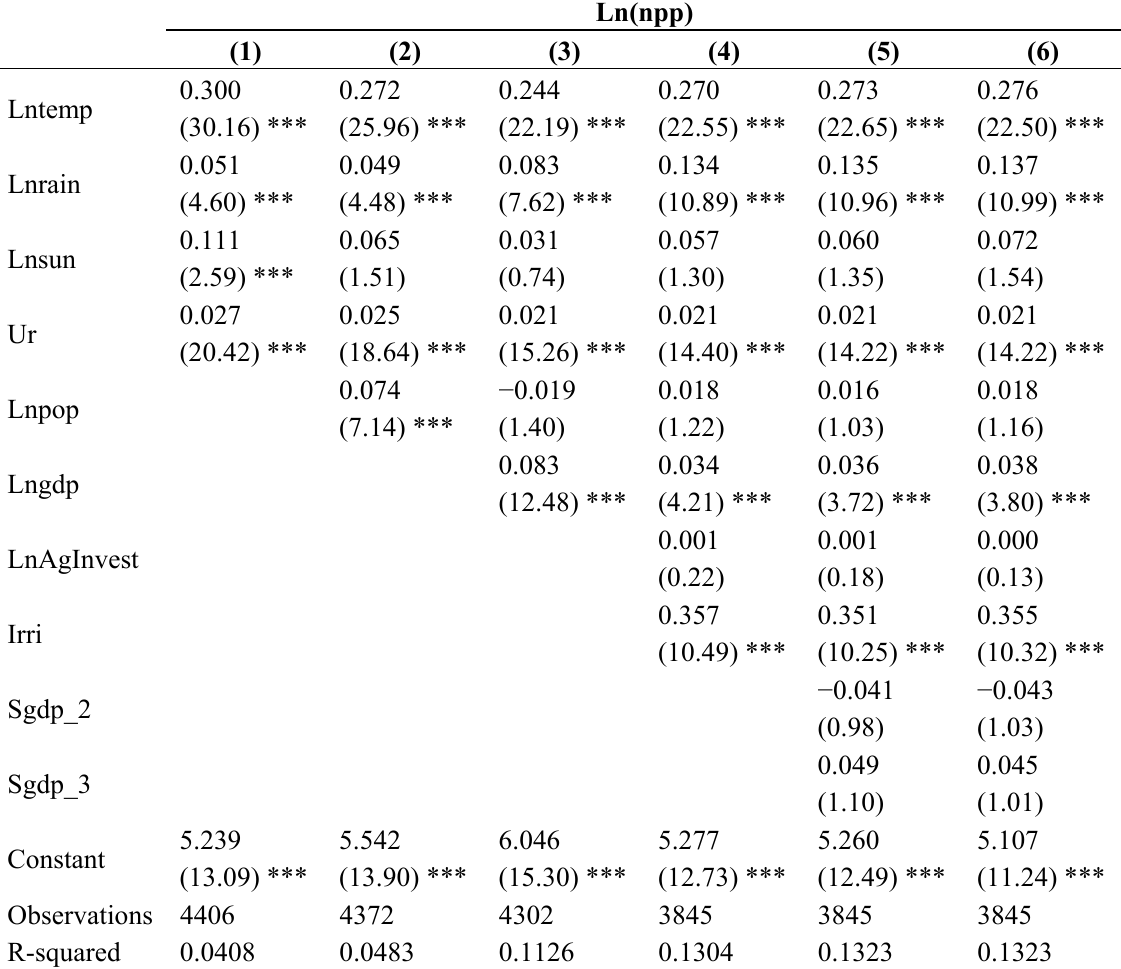
Table 3. Results from the panel-data model of the changes in carbon bio-sequestration in